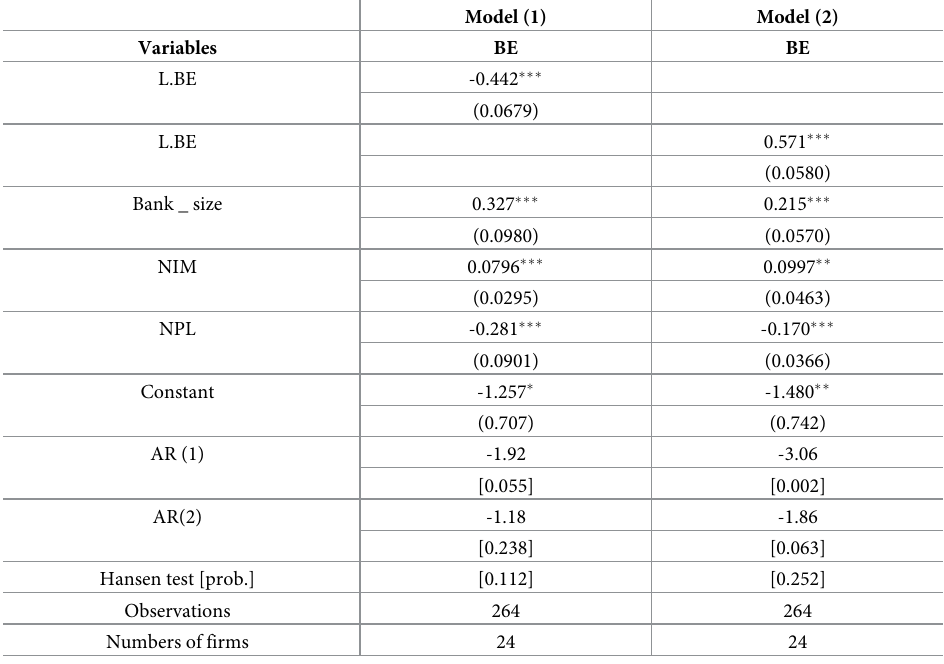
Table 7. System—GMM